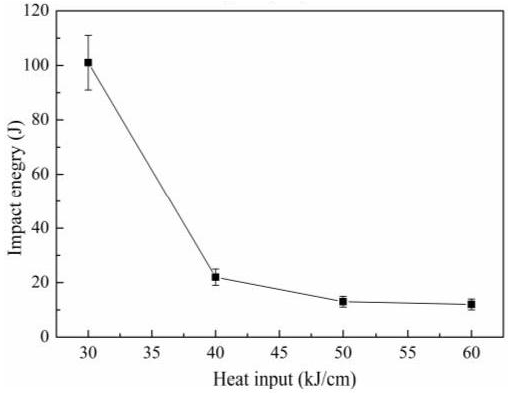
Figure 8. Charpy impact energies of the specimens with different heat inputs.